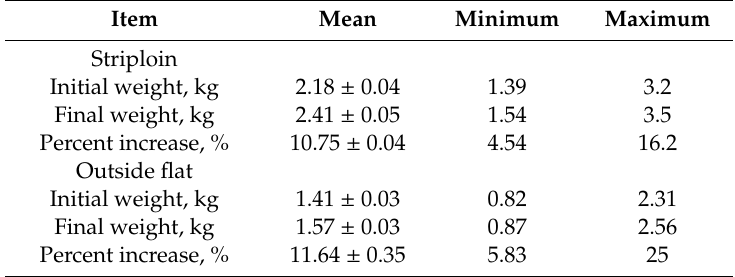
Table 2. Mean ( ± SEM), minimum, and maximum increase in muscle weights for striploins ( M. longissimus lumborum ) and outside flats ( M. biceps femoris ) enhanced with a kiwifruit extract.